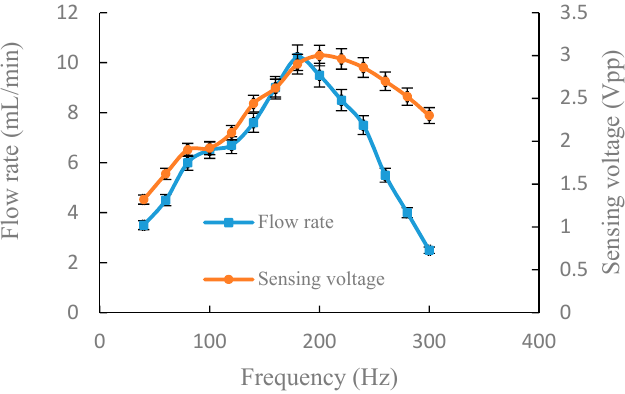
Figure 6. Output flow rate and sensing voltage under a fixed voltage of 150 Vpp in parallel connection.